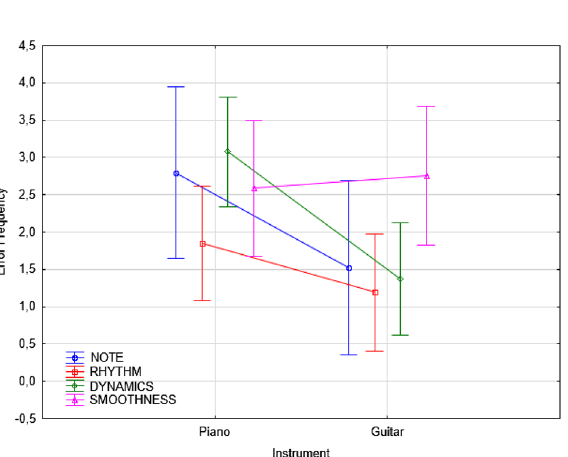
Figure 3. Error frequency observed for the two musical instruments and as a function of the learning condition. Error bars indicate standard errors.